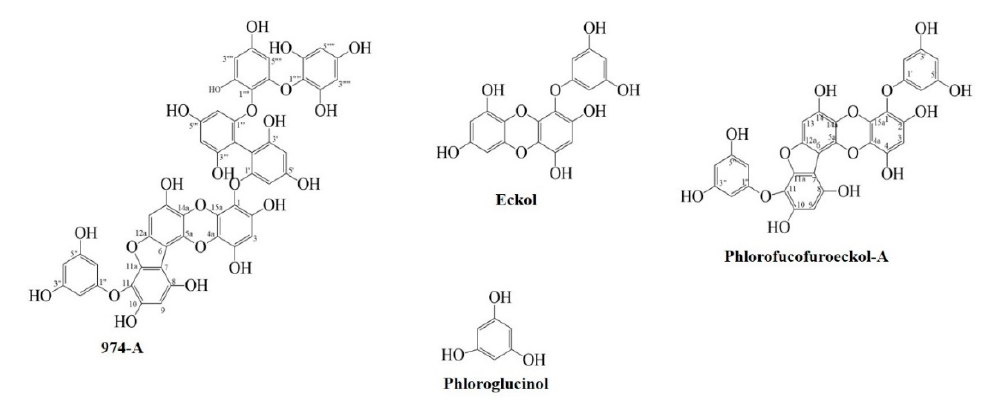
Figure 1. Structure of compounds isolated from Ecklonia stolonifera.